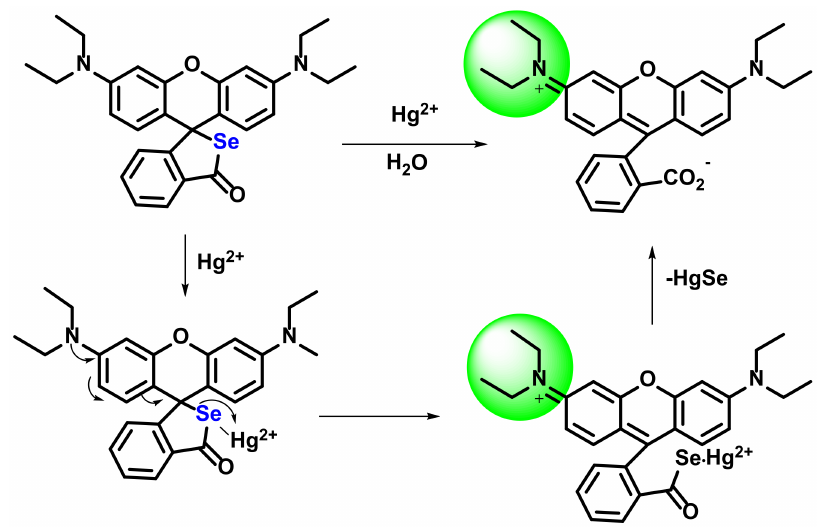
Figure 12. Sensing mechanism of rhodamine-based chemosensor for Hg 2+